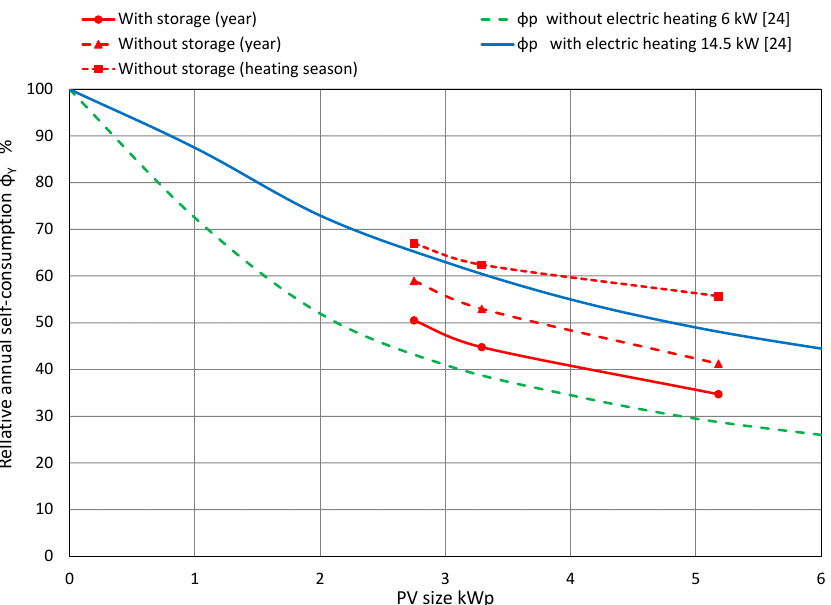
Figure 17. Comparison of calculated relative coefficient PV self-consumption to PV size averaged over all 200 households [12].